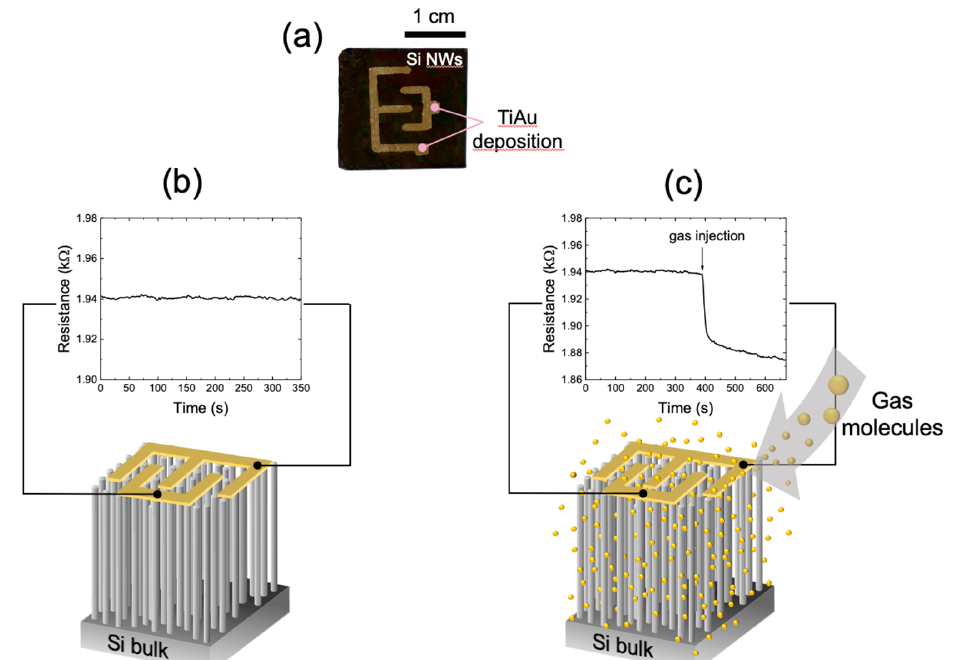
Figure 5. ( a ) Photograph of the sensor (2 × 2.3 cm 2 ) composed of Si NWs platform (black color) covered by the interdigitated electrode. Pictures of the resistance variation of the silicon nanowires before ( b ) and after ( c ) the presence of the gas target. The electrodes are drawn in yellow above the Si NWs surface.